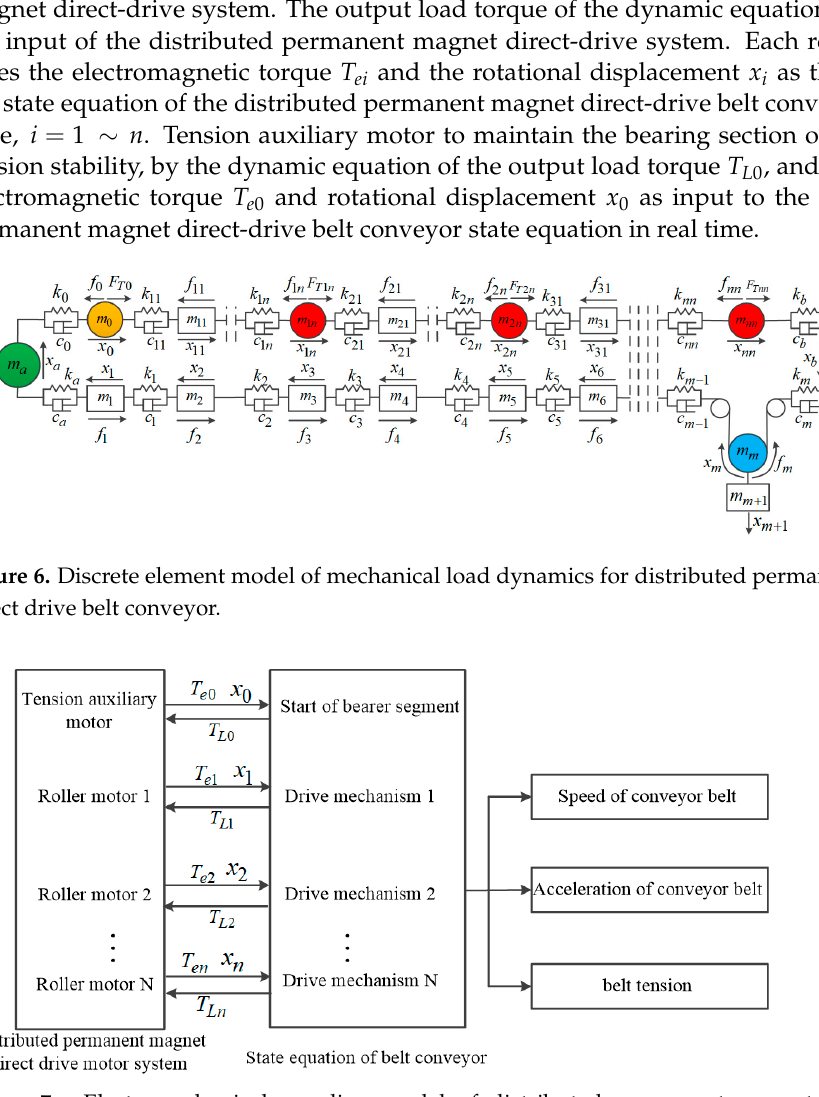
Figure 7. Electromechanical coupling model of distributed permanent magnet direct-drive belt con-